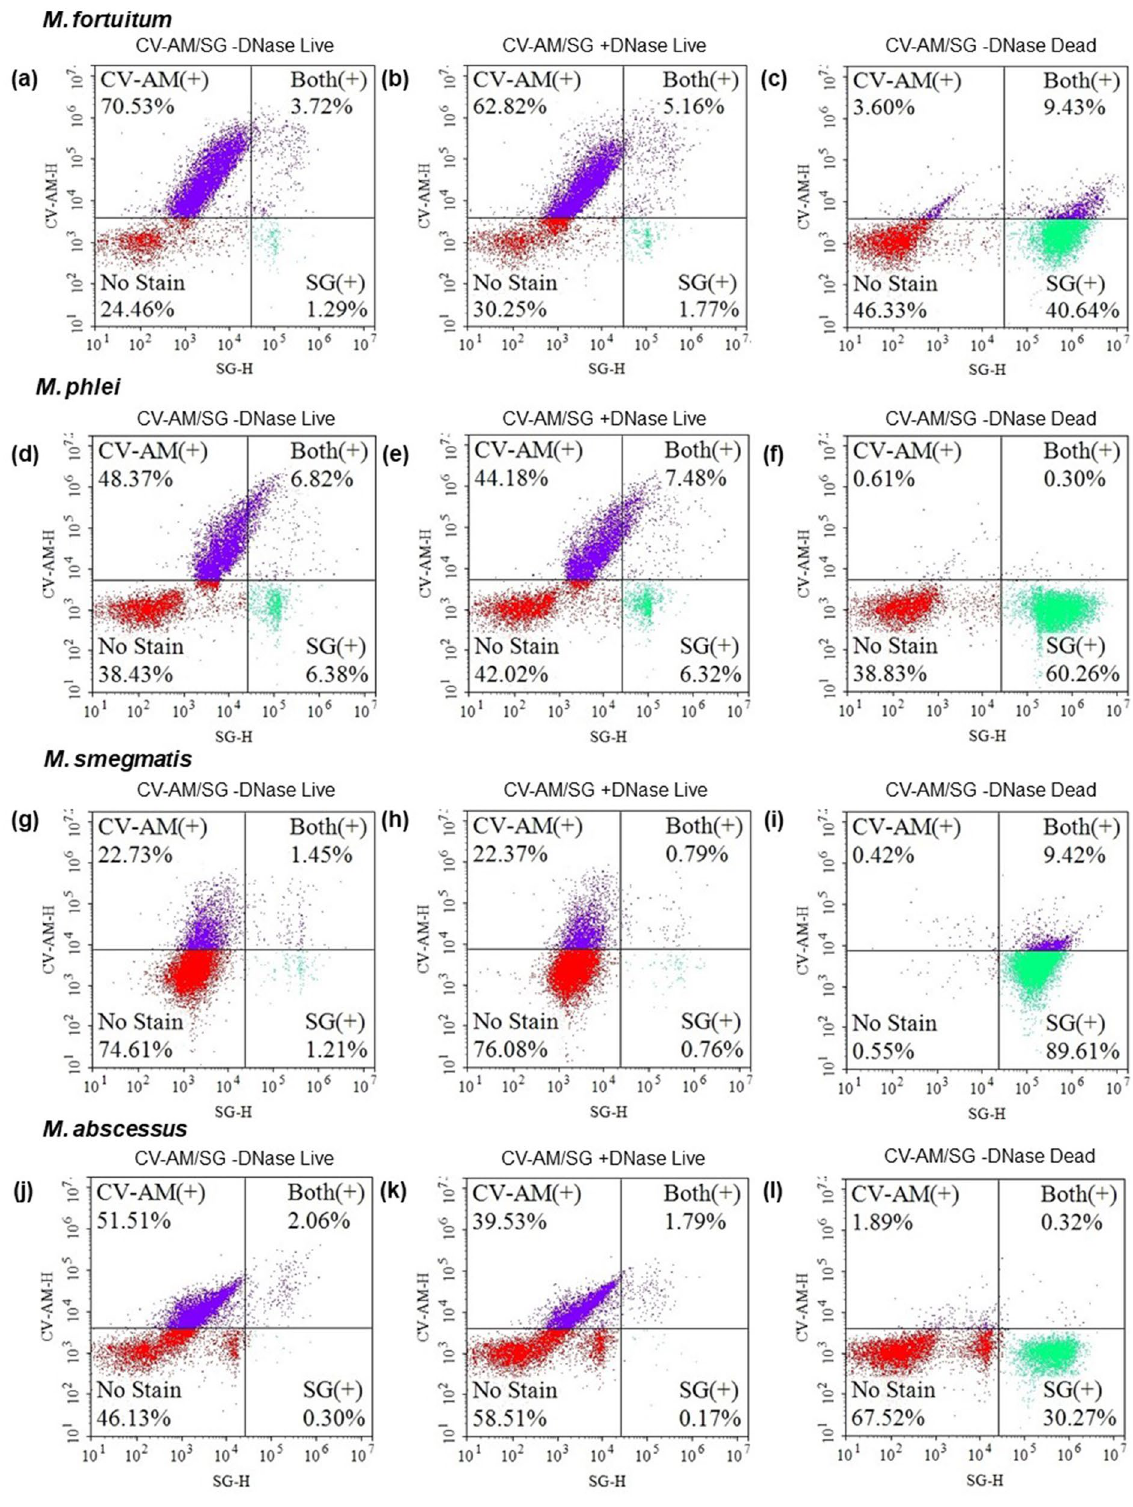
Figure 2. FACS analysis of extracellular DNA (eDNA) on M. fortuitum, M. phlei, M. smegmatis, and M. abscessus in 7H9-ADC broth. Representative NovoCyte Flow Cytometer plots of M. fortuitum ( a , b , and c ), M. phlei ( d , e , and f ), M. smegmatis ( g , h and i ), and M. abscessus ( j , k , and l ) stained by calcein violet with an acetoxy-methyl ester group (CV-AM) typical of live cells and SYTOX Green (SG) stains DNA, respectively. Bacteria were treated with Benzonase Nuclease I ( b , e , h , and k ) or heated at 95 °C for 5 min ( c , f , i , and l ) before